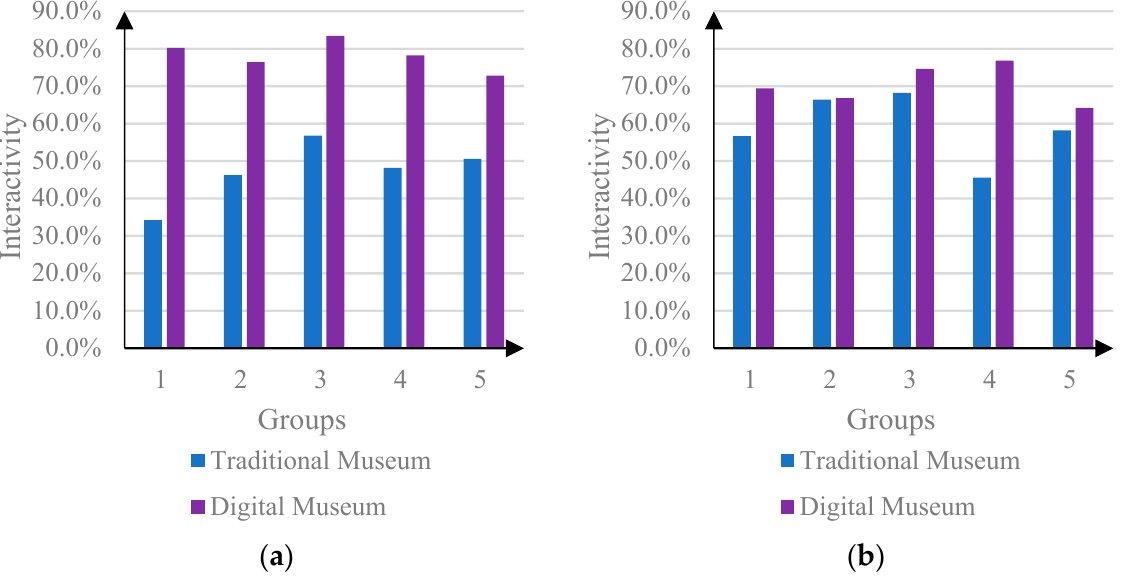
Figure 5. Interactive comparison results. ( a ) Interactivity of museums from the perspective of young people, ( b ) Interactivity of museums from the perspective of the elderly.